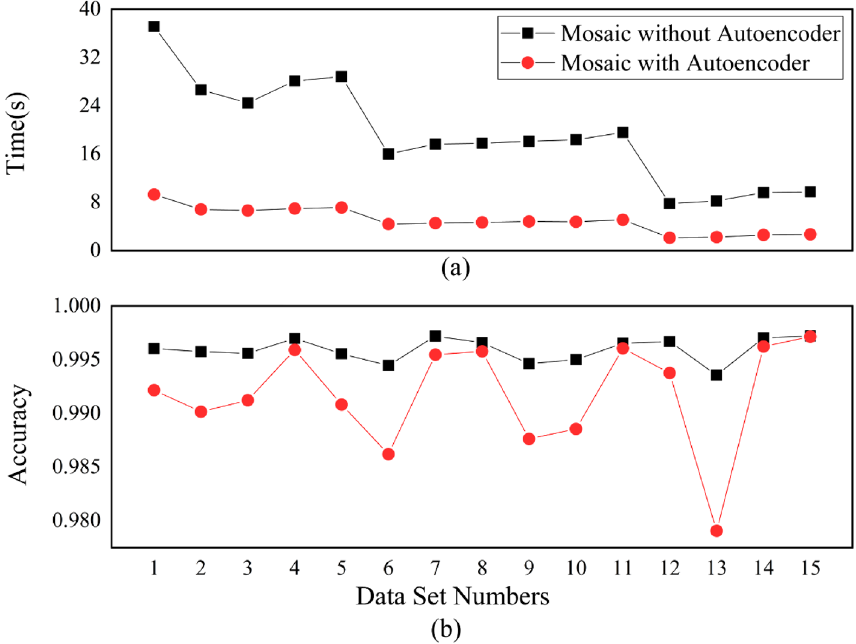
Figure 16. Comparison of model’s test running time and the overall accuracy under different invasion combinations with and without autoencoder for dimension